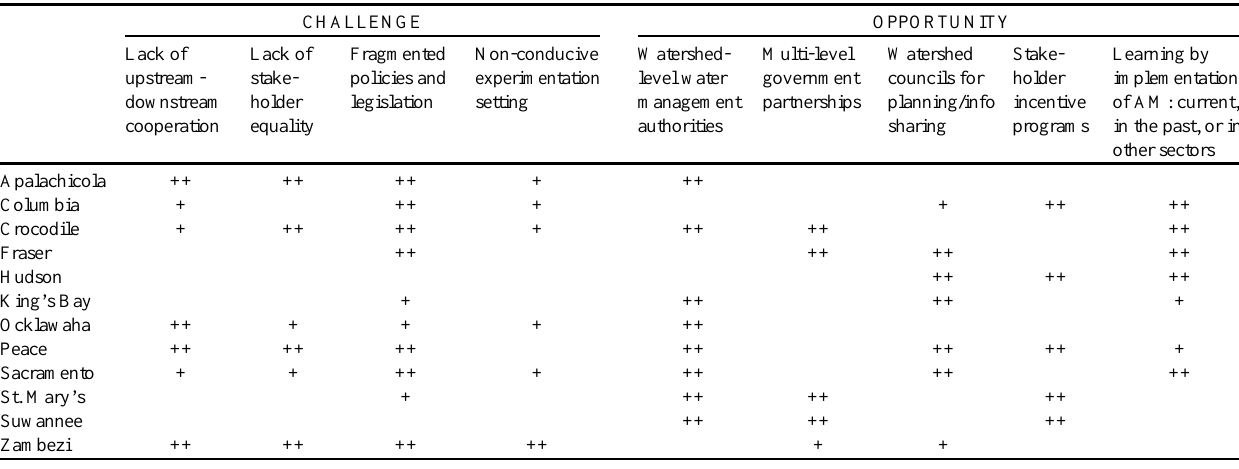
Table 3 . Common challenges and opportunities for watershed management and the adoption of AM practices. The degree to which each challenge or opportunity is present in a given watershed is indicated by “+” for a relevant challenge or opportunity and “++” for a major challenge or